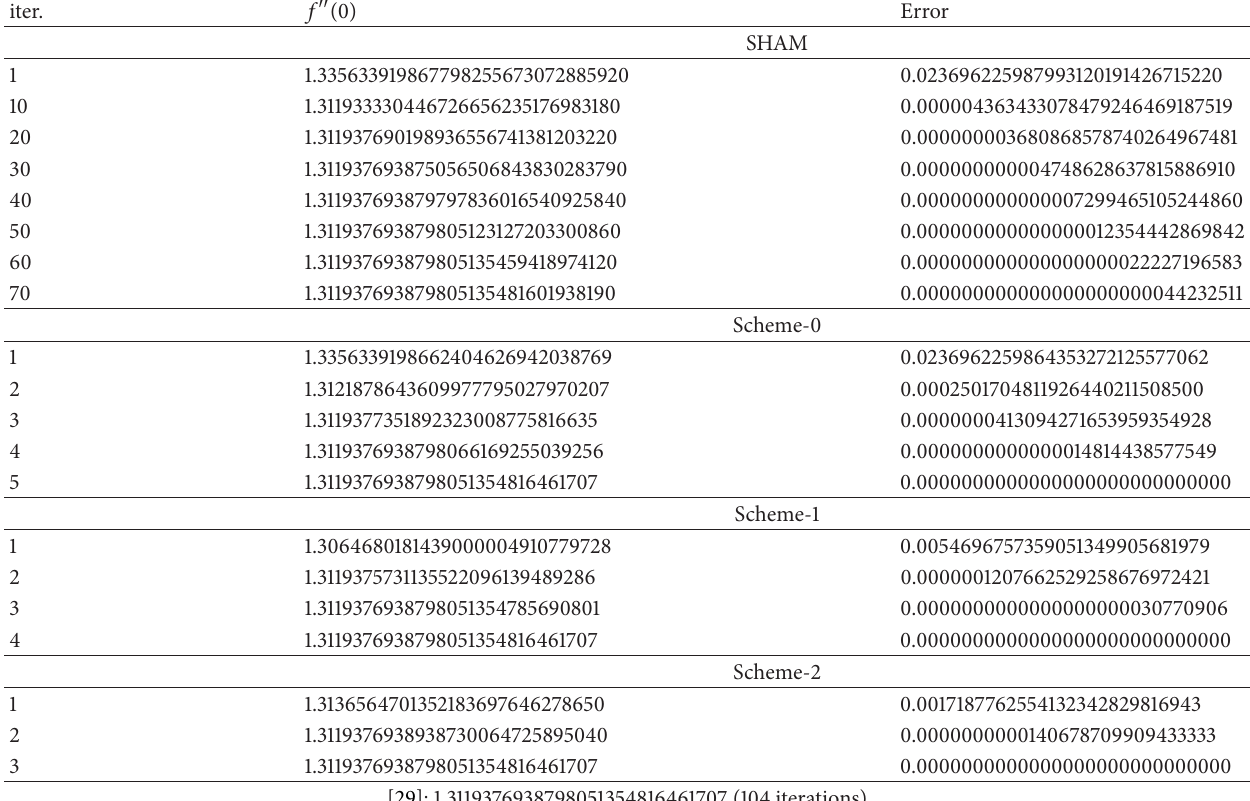
Table 3: Comparison between the computed values of the skin friction 𝑓󸀠󸀠(0) for the Homann flow (𝛽 = 2, 𝛽 1 = 1) .